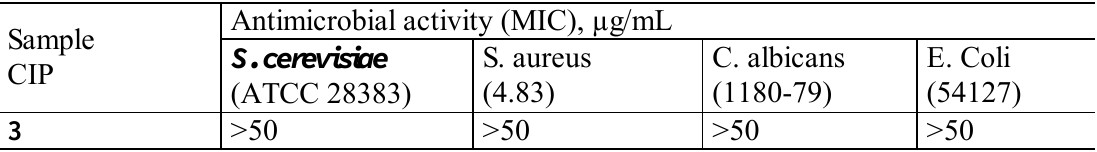
Table 2. Antimicrobial activity of Schiff base